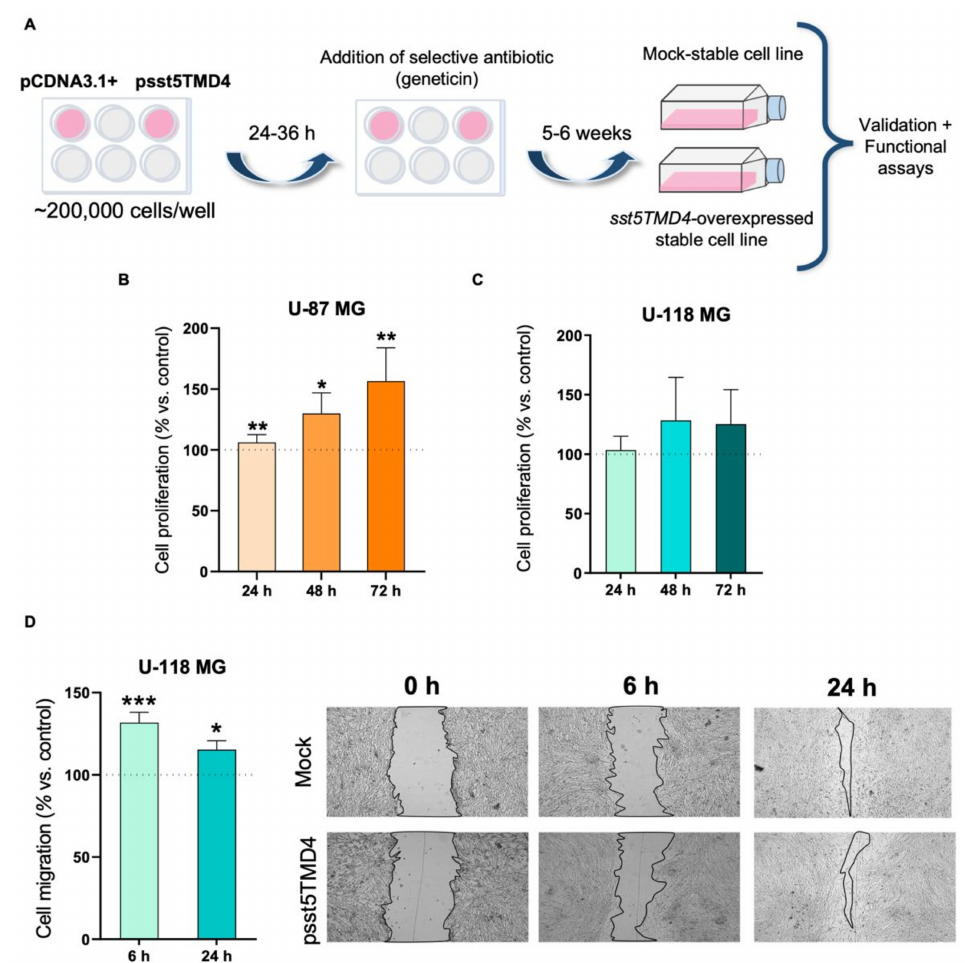
Figure 2. Stable sst5TMD4 overexpression increases oncogenic parameters in vitro in glioblastoma cells. ( A ) Schematic workflow to obtain stable overexpressed sst5TMD4 U-87 MG and U-118 MG cell lines. Proliferation rate of sst5TMD4 -overexpressed cells compared to control (mock-transfected cells; pointed line) in U-87 MG ( B ) and in U-118 MG ( C ) ( n = 3). ( D ) Migration rate of sst5TMD4 - overexpressed U-118 MG cells compared to control (mock-transfected cells; pointed line; n = 3). Representative images of the migration capacity are also included. Data represent means ± SEM. (*) p < 0.05, (**) p < 0.01, (***) p < 0.001 significantly differ from control